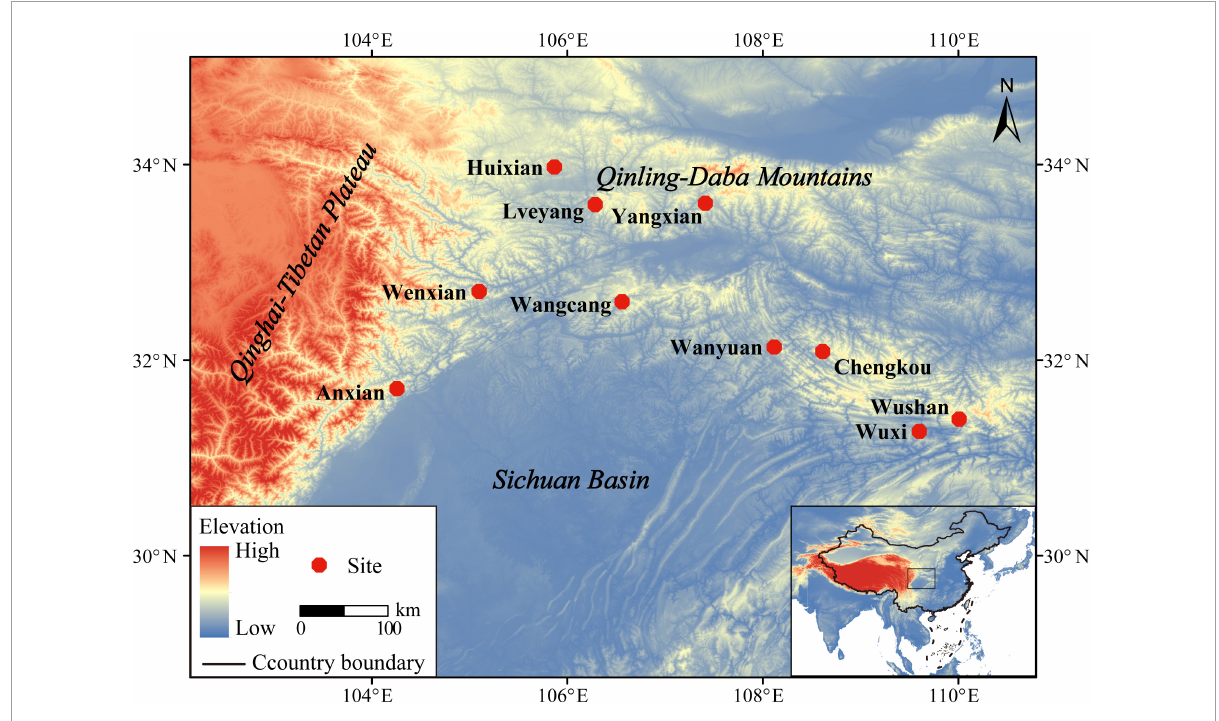
FIGURE1 Topographic maps showing the sampling locations of 10 populations in Feirana quadranus in China.